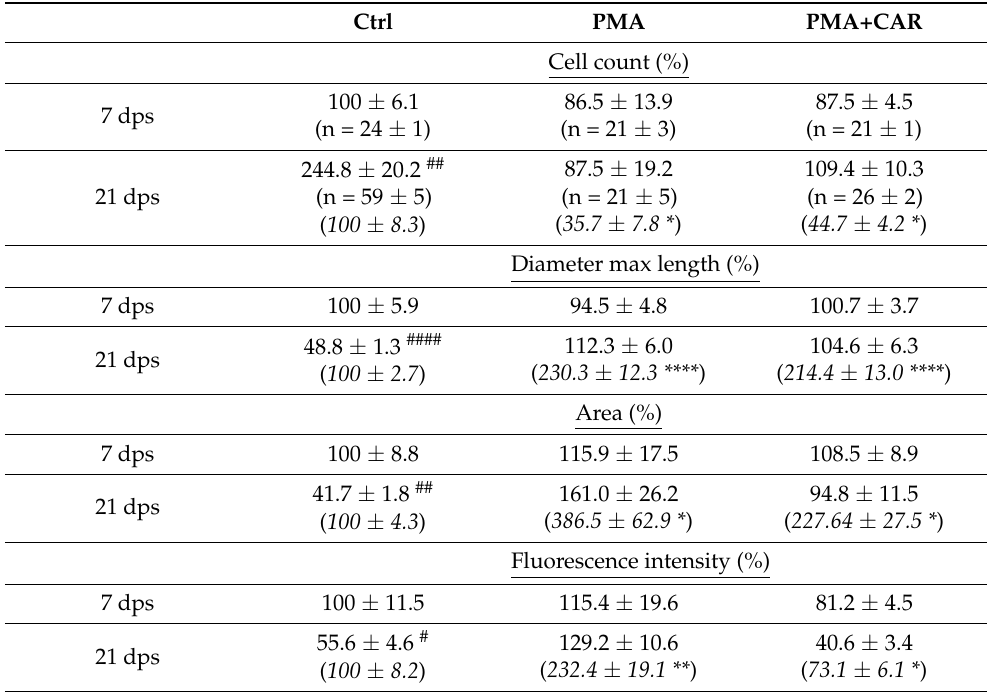
Table 2. Effects of PMA and PMA+CAR on morphometry values in 7 and 21 dps Caco-2 monolayers. Cell count and measures refer to area units = 450 × 600 µ m. Maximum diameter, individual cell area, and actin fluorescence intensity are measured and normalized by ImageJ analysis software (see Materials and Methods for details). Data are presented as mean ± SEM of five measures from each of three independent biological replicates; for cell counts, absolute mean values (n) are reported with bold characters in round brackets. In bold black, mean values are expressed as percent respect to untreated control at 7 dps (100%); limited to 21 dps data, mean values are also reported in italics (in brackets) as percent respect to untreated control at 21 dps (100%); significant differences are represented by individual symbols; #: vs. control at 7 dps; *: vs. control at 21 dps. Statistical analysis: one-way ANOVA with Dunnett correction for multiple comparisons ( # /* p < 0.05; ## /** p < 0.01; #### /**** p <